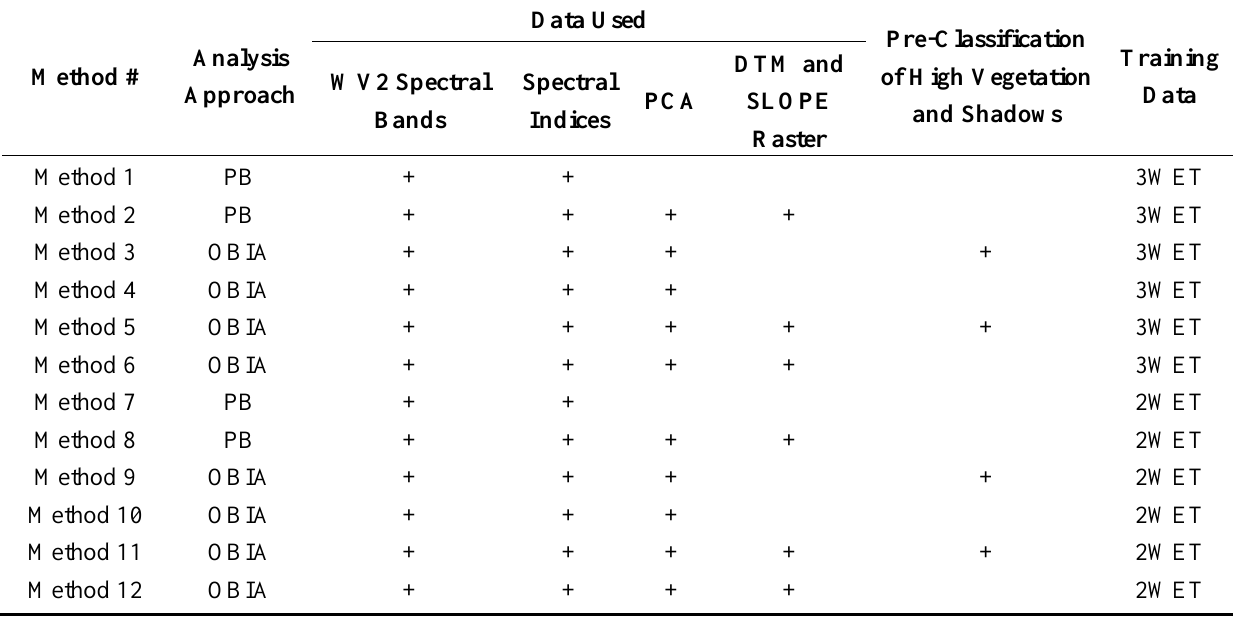
Table 3. Specification of the classification methods developed and used in this